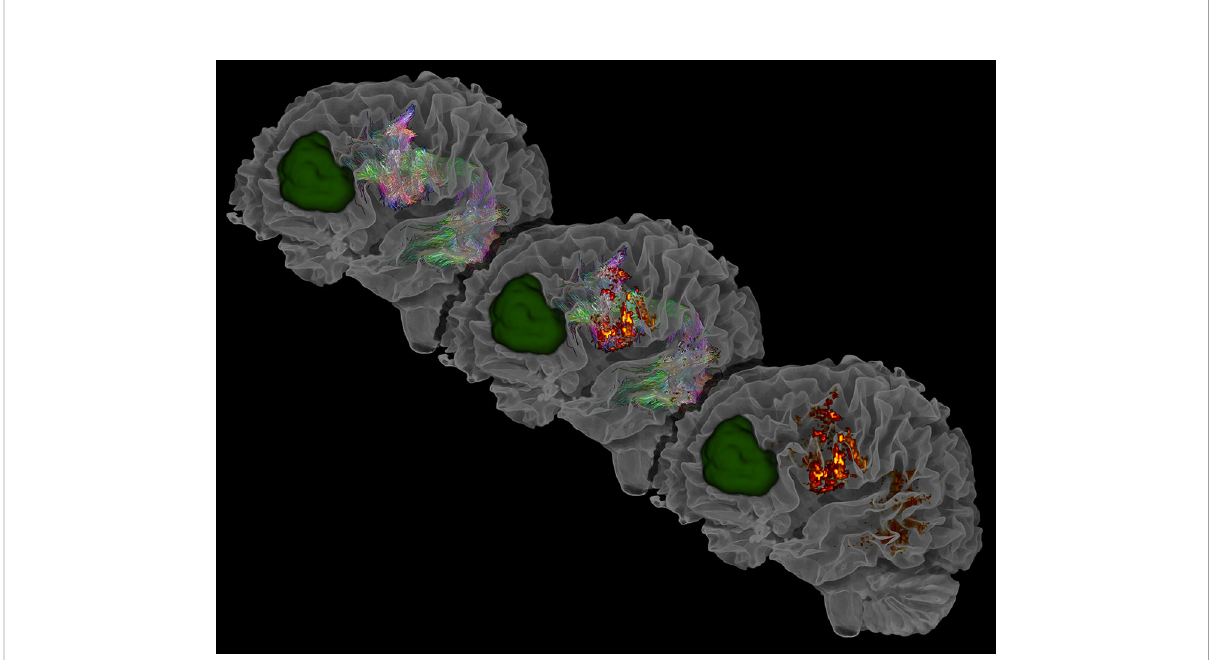
FIGURE 1 Exemplary visualization of the AF, the AF ’ s corresponding segmented endpoints, and segmented tumor lesion (green), segmented using ITK-SNAP (42). Visualized are three sequential stages: the initial tractogram (top left), the tractogram with its cortical endpoints (middle), and the resulting cortical endpoints of the tractogram (bottom right). The AF is visible through the transparency setting of the white matter mask. In the frontal region, streamlines can be seen running anterior-posterior (green), showing proximity to the tumor and emphasizing the importance of preoperative mapping. Laterally and posterior to the tumor, reddish streamlines indicating left-right directions can be observed ending in the left